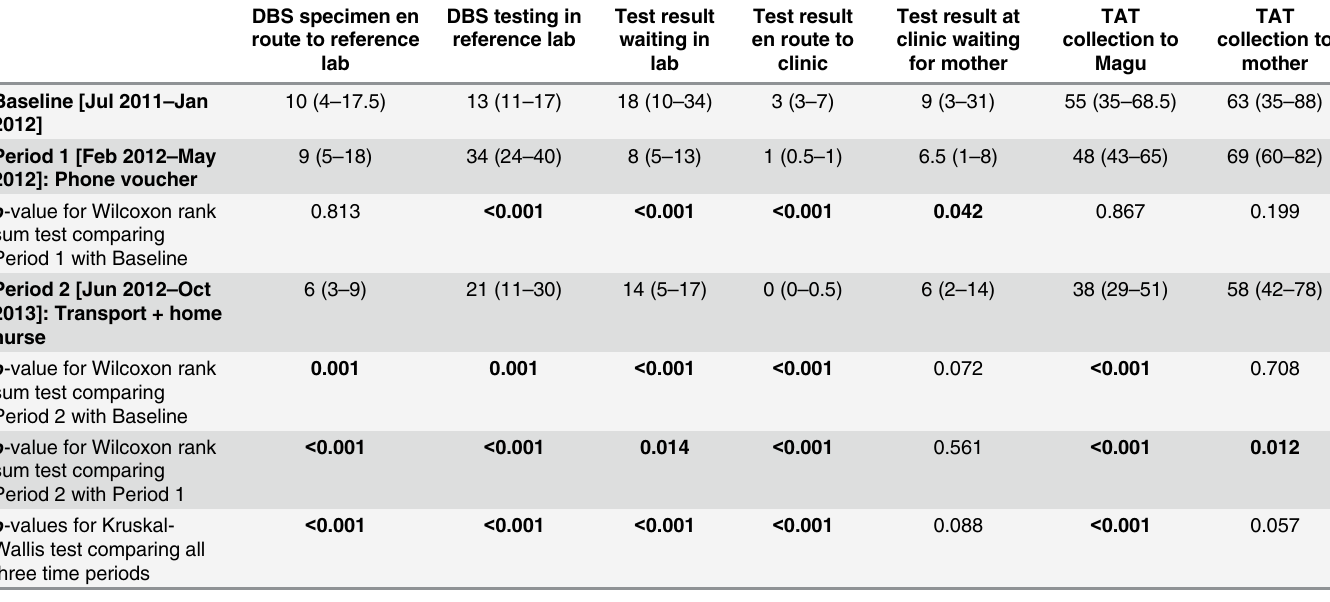
Table 1. Median (interquartile range) number of days required for sequential steps for DBS testing over consecutive intervention